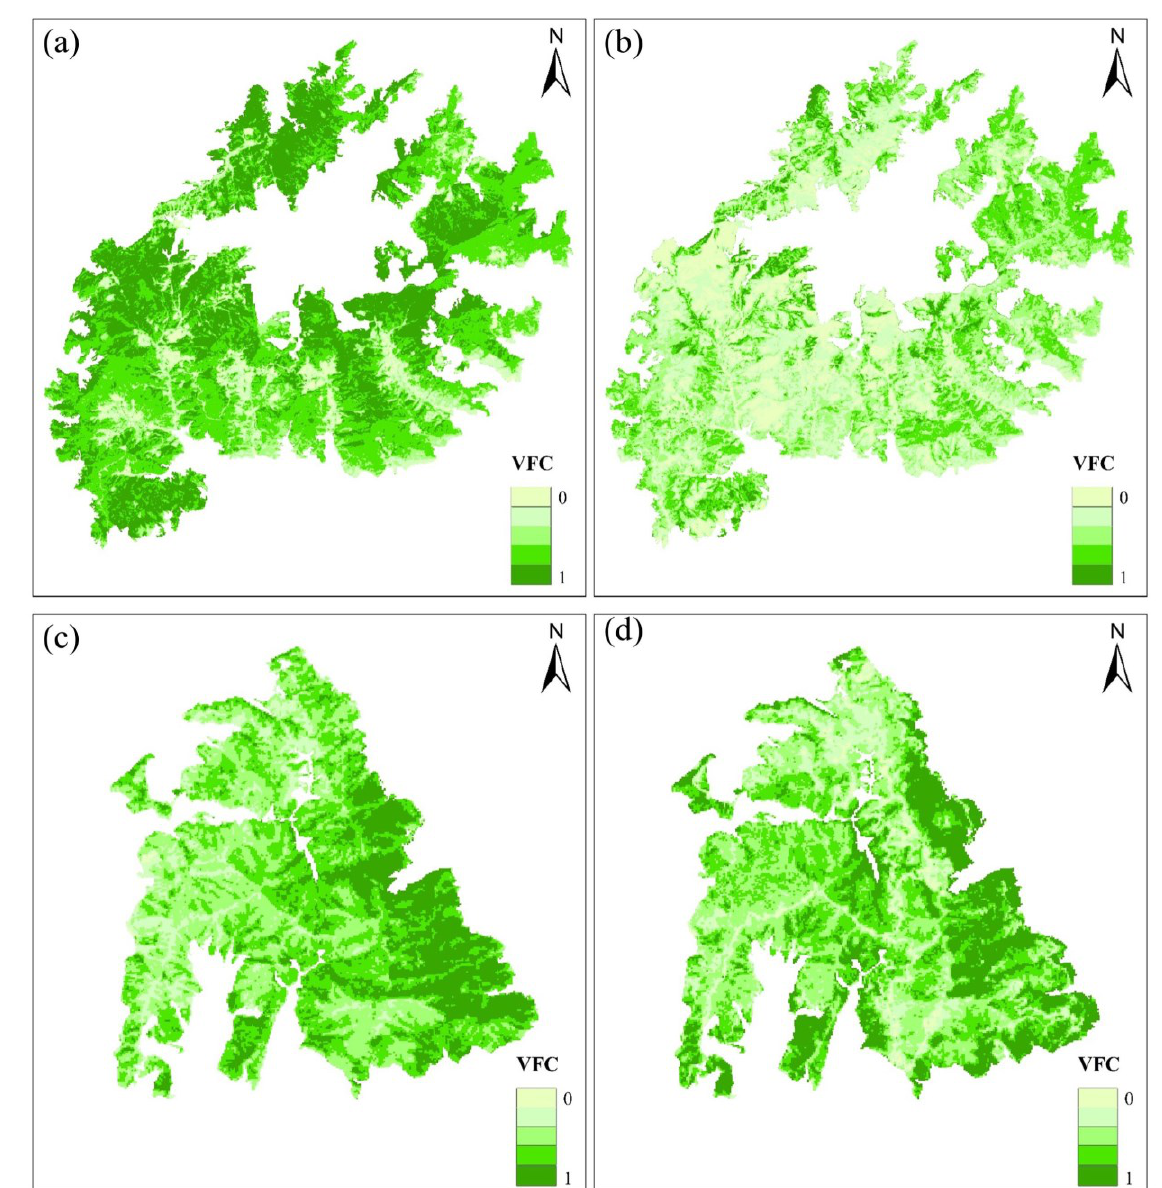
Figure 9. Changes in vegetation coverage before and after the fire. ( a , b ) the VFC before and after the fire in Muli County, respectively, ( c , d ) the VFC before and after the fire in Jingjiu Township, respectively.